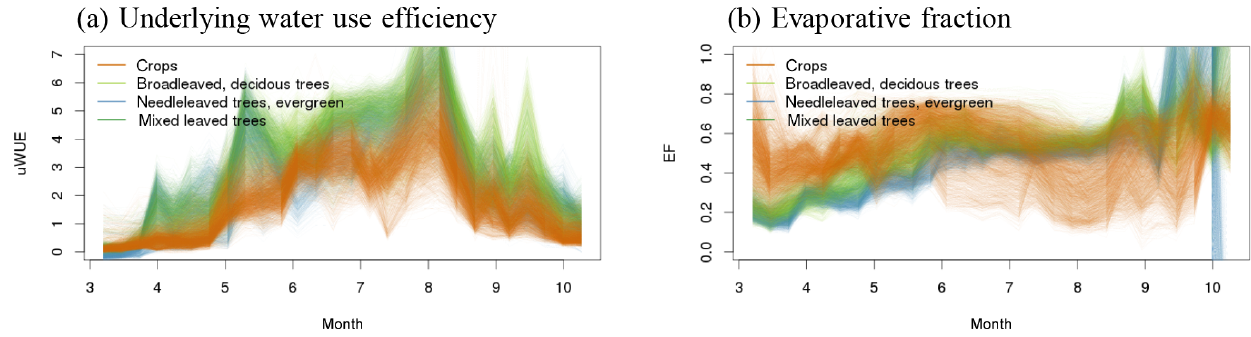
Figure E1. (a) Underlying water use efficiency (uWUE) and (b) evaporative fraction (EF) of the area affected by the RHW in 2010. uWUE is calculated according to Zhou et al. (2014) including vapor pressure deficit. In contrast to WUE, uWUE attempts to correct for differences in temperature and vapor pressure deficit to a certain